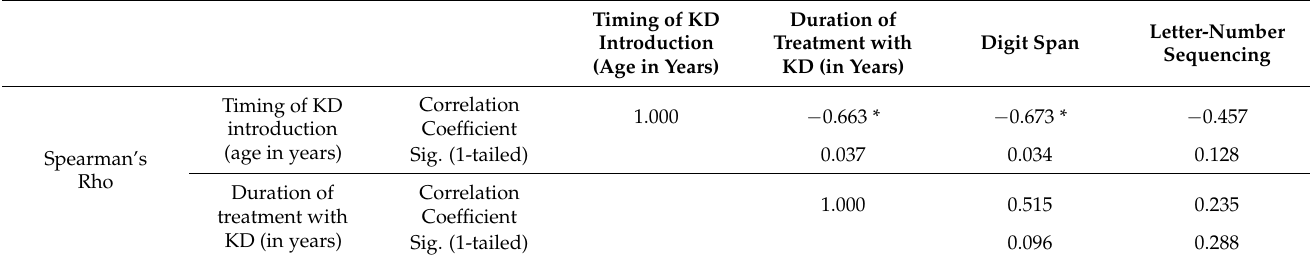
Table 6. Correlation between subtests of working memory index (WMI) and timing of KDT introduc- tion/duration of treatment with KDT.